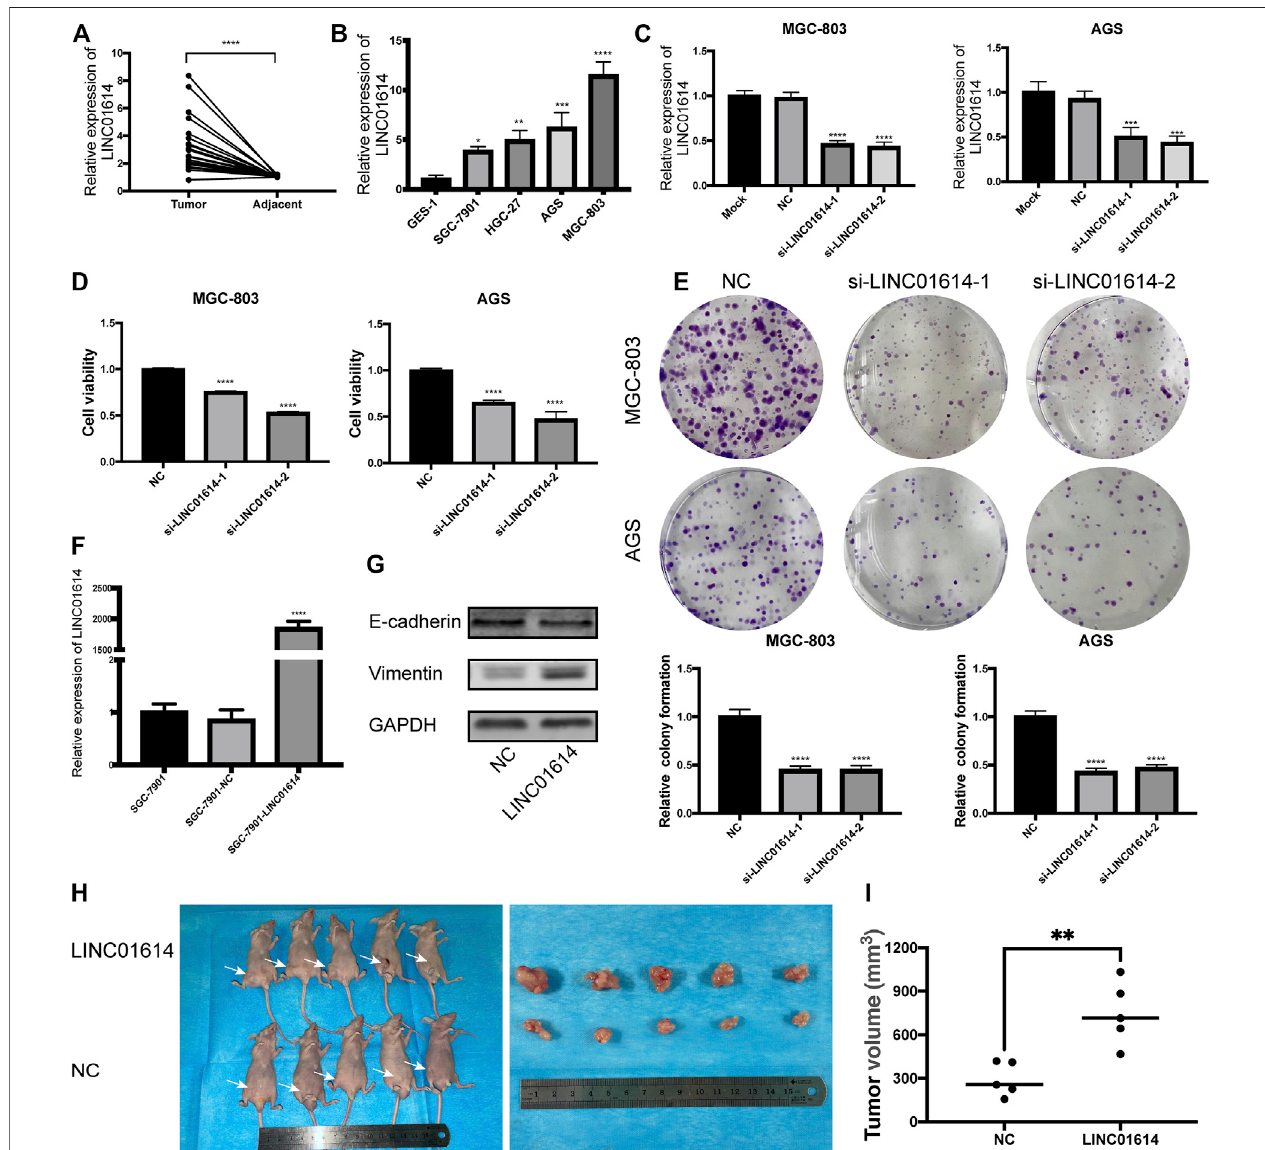
FIGURE 4 | LINC01614 expression is upregulated in gastric cancer (GC) tissues and cell lines, and promotes tumor growth (A) LINC01614 expression in 22 GC tissues and paired adjacent normal tissues determined by performing quantitative real-time polymerase chain reaction (qRT-PCR). (B) The expression of LINC01614 in 4 GC cell lines and immortalized human gastric epithelial cell line detected by performing qRT-PCR. (C) qRT-PCR analysis of the expression of LINC01614 in MGC-803 and AGS cells after performing knockdown of LINC01614 . (D) Cell Counting Kit-8 assay was used to analyze the cell proliferation of MGC-803 and AGS. (E) Colony formation assay was performed to detect the colony number of MGC-803 and AGS cells. (F) The effectiveness of LINC01614 overexpression-based transfection was assessed through qRT-PCR. (G) Expression of epithelial mesenchymal transition markers was quanti fi ed using western blotting after overexpressing LINC01614 . (H – I) Tumor volume between control and LINC01614 -overexpression group showed signi fi cant difference in xenograft assay.